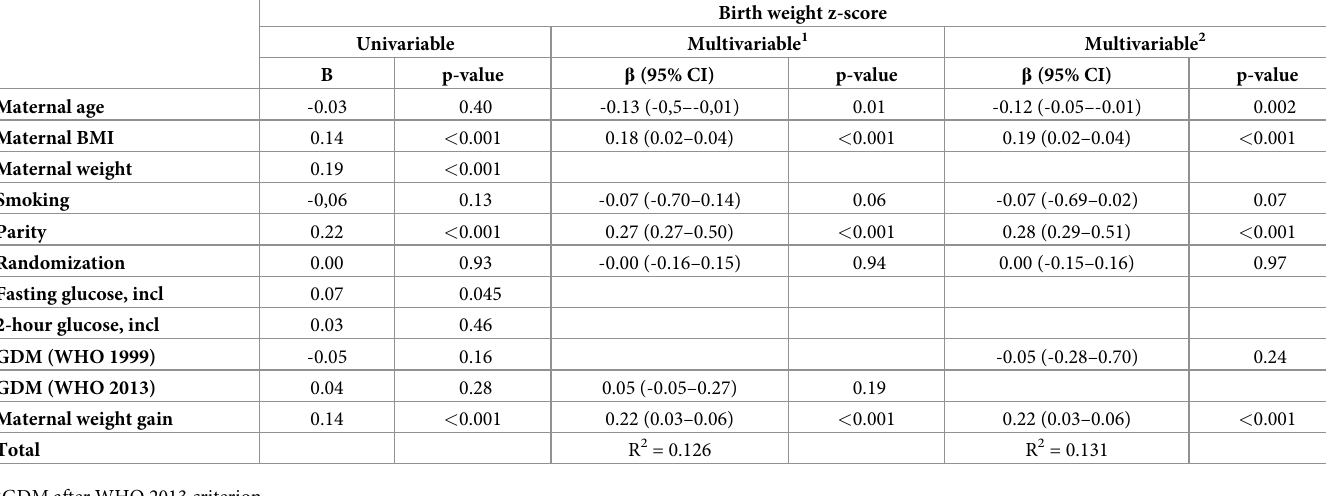
Table 3. Determinants of offspring birth weight (z-score) in women with PCOS, linear